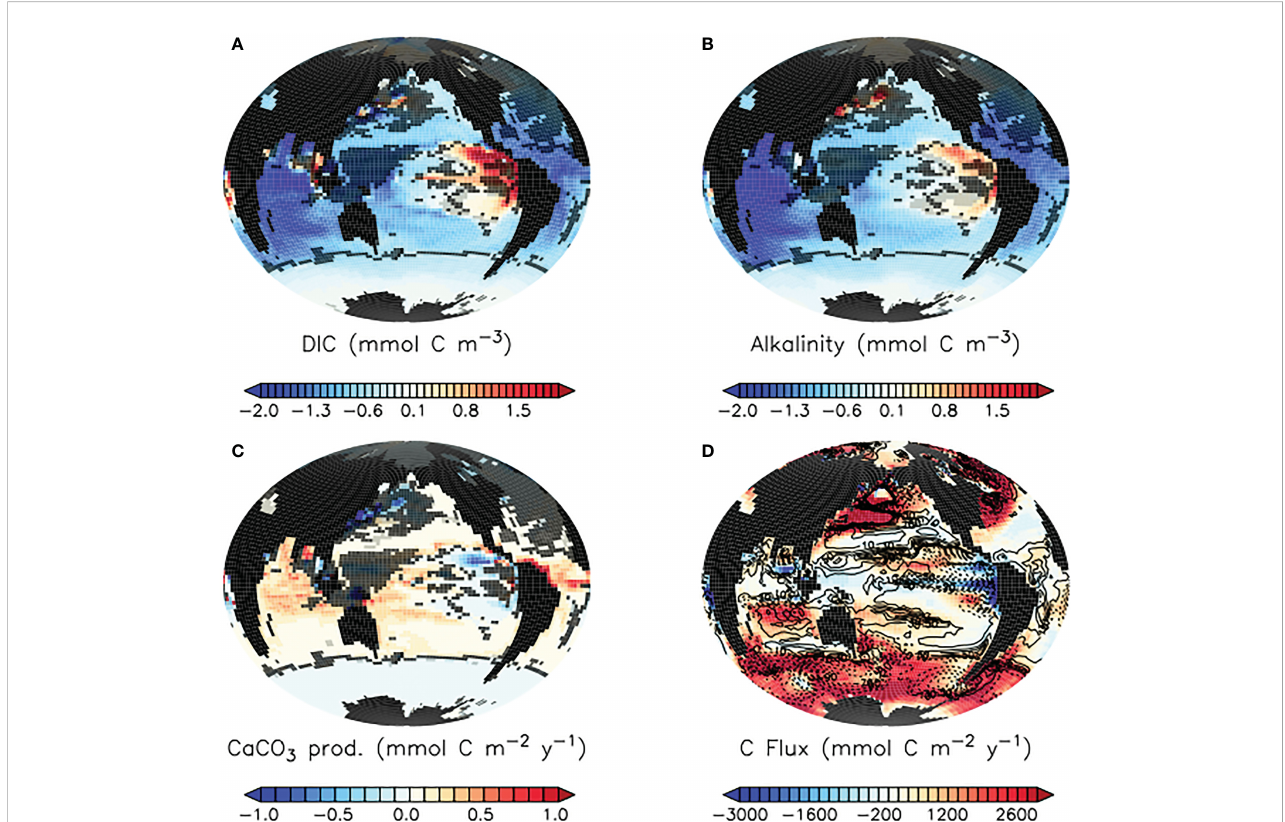
FIGURE 10 Model ensemble mean differences (SLOW small - CNTL) in simulated surface dissolved inorganic carbon (A) , alkalinity (B) , and carbonate production by plankton (C) , and SLOW small model ensemble mean air-sea carbon fl uxes (D) at the year 2100. In (A – C) , model response in regions shaded in light grey are highly variable in magnitude across the model ensemble. Model response in regions shaded in dark grey do not agree in sign across the model ensemble. In panel D,positive values represent fl uxes into the ocean while negative values are fl uxes out of the ocean. Overlaid in panel (D) are SLOW small - CNTL model ensemble mean carbon fl ux differences in mmol C m -2 y -1 . Dashed contours indicate enhanced carbon outgassing in blue shaded regions, and reduced carbon uptake in red shaded regions. Differences in SLOW big - CNTL are provided as Supplemental Figure